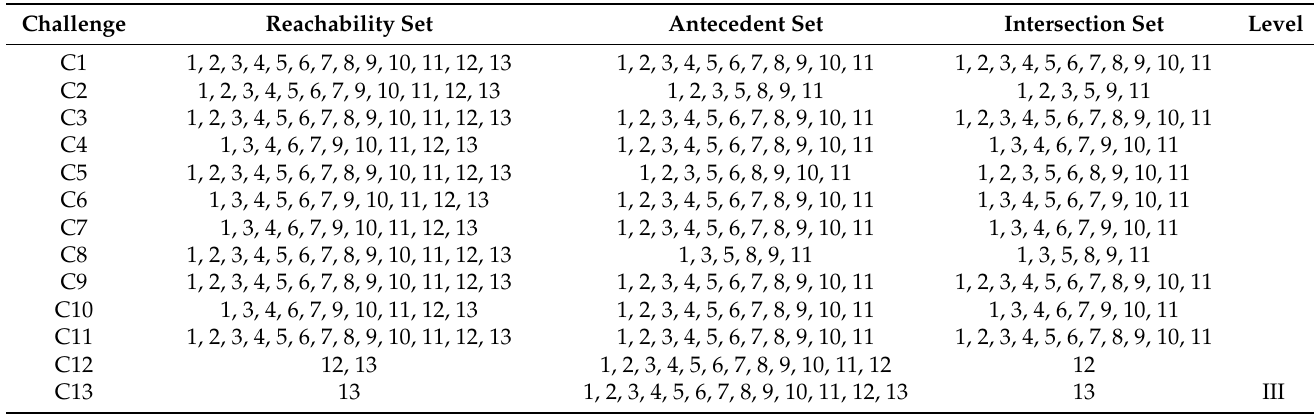
Table 9. Iteration